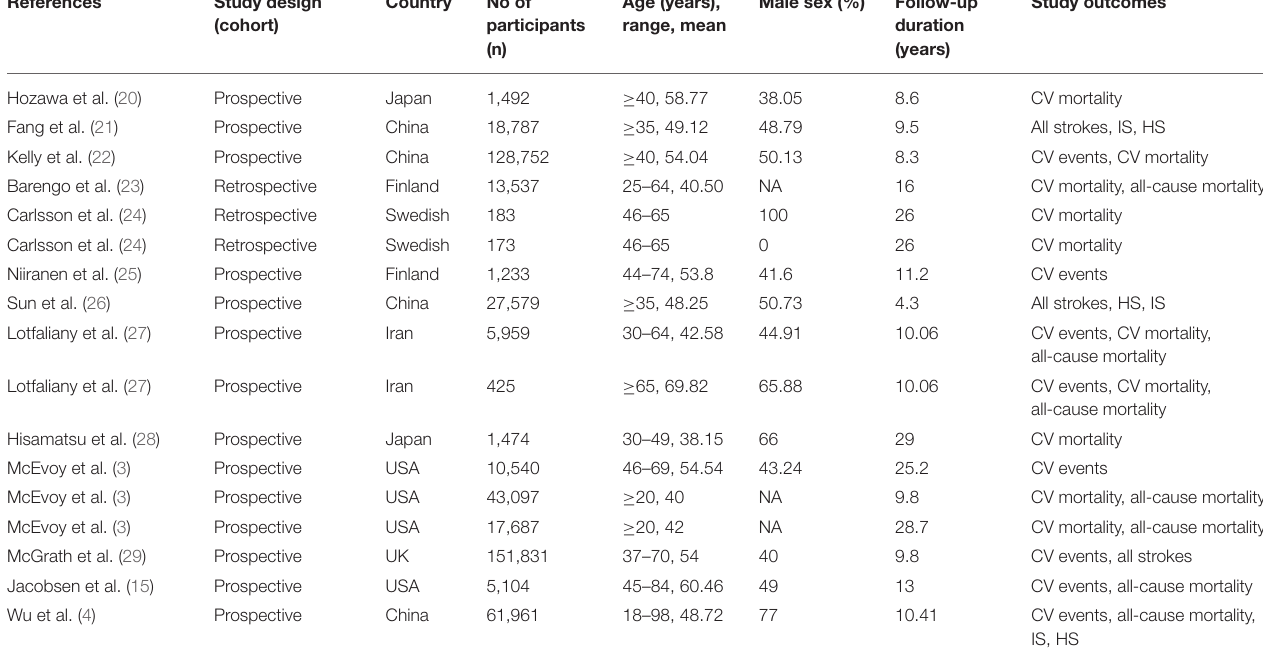
TABLE 1 | Characteristics of studies included in the